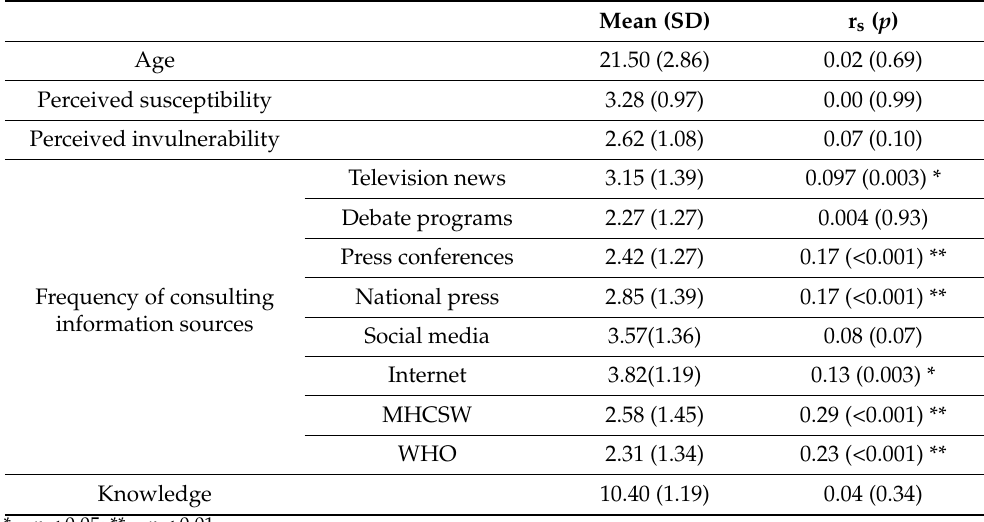
Table 3. Quantitative variables. Correlations with